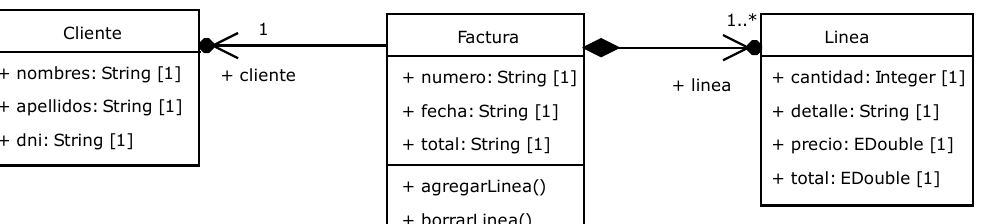
Figure 13. UML class diagram.